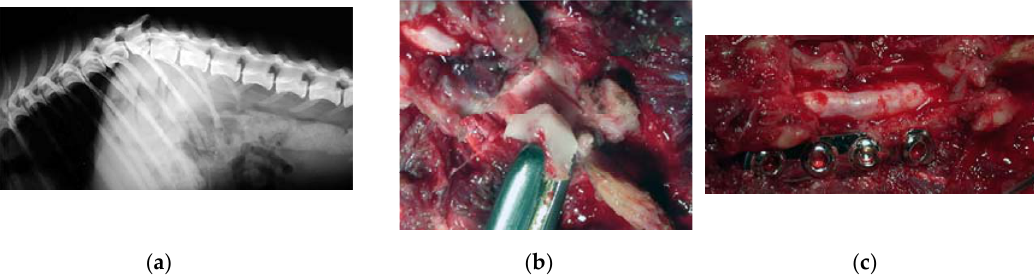
Figure 5. X ‐ ray showing a T13 ‐ L1 fracture with hyperkyphosis in a paraplegic dog ( a ). A safe thoracic piezoelectric laminectomy was obtained with an angled sharp tip (OT2, Osteotomy Tips Kit, Mectron Medical Technology, Genoa, Italy) piezoelectric bone scalpel ( b ). Dorsal monolateral vertebral stabilization T13 ‐ L1 with plate and screws. Noteworthy, piezoelectric scalpel with a different straight tip was used as tapper for the screws placement ( c ).